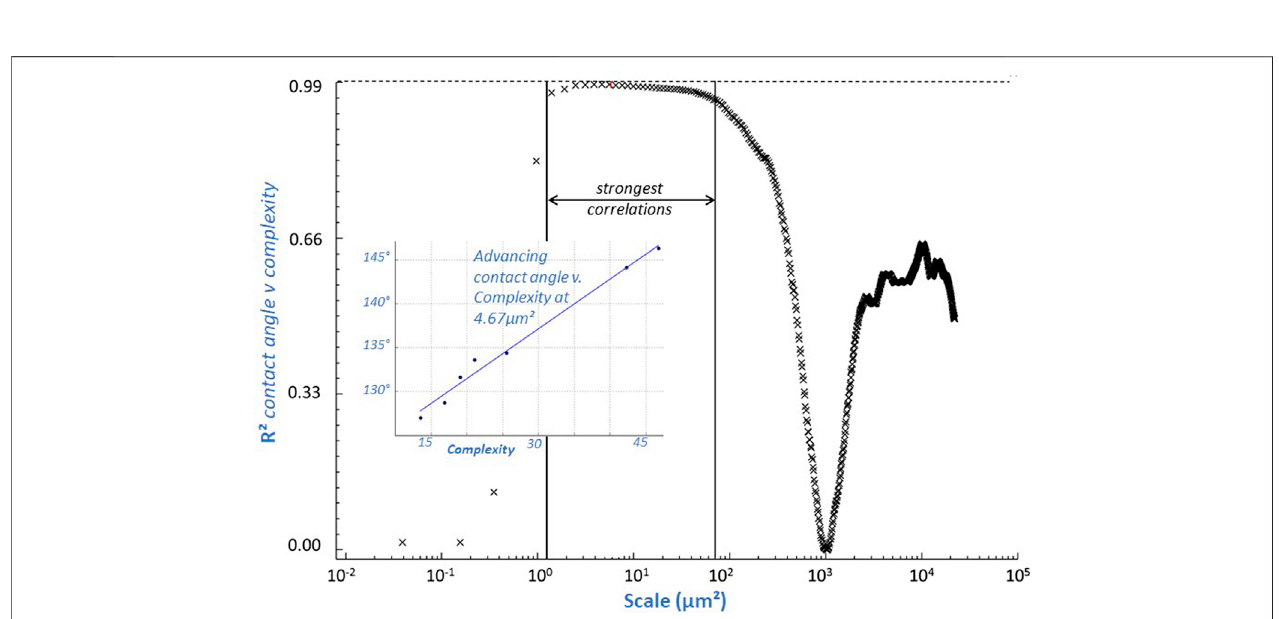
FIGURE 3 | R 2 versus scale. Regression coef fi cients for advancing contact angles regressed versus area-scale complexities. The scale range for the strongest correlations are noted. The insert shows a regression line in this range, at 4.67 μ m 2 .